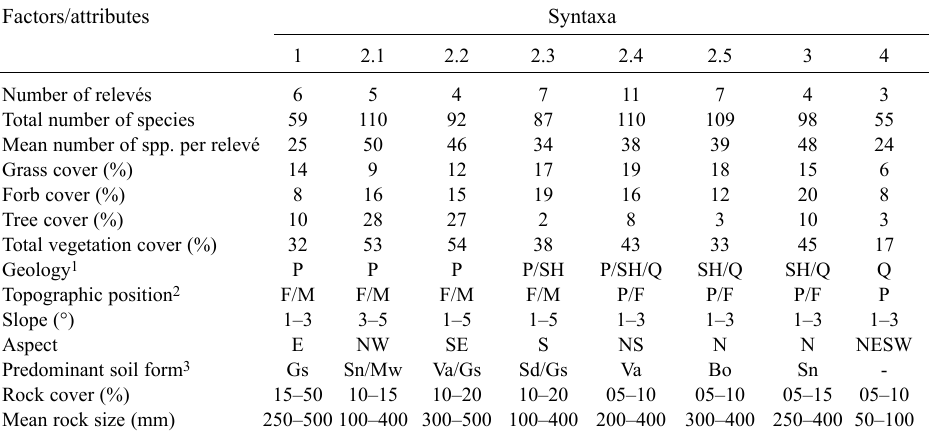
Environmental factors and selected attributes associated with the different plant communities of the Potlake Nature Reserve and surrounding areas Factors/attributes